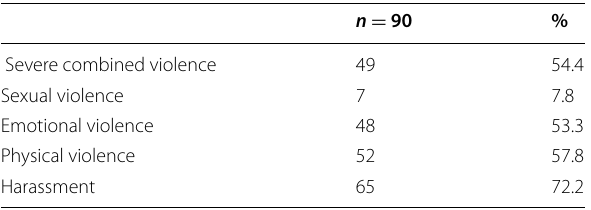
Table 2 Types of intimate partner violence among studied